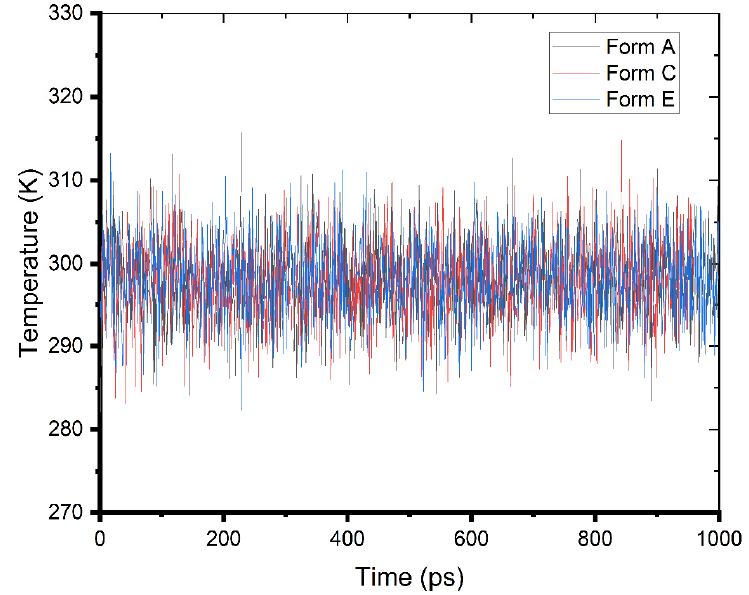
Figure 8. Temperature fluctuation (T = 298 K) during the MD run in the simulated corrosion me- dia.